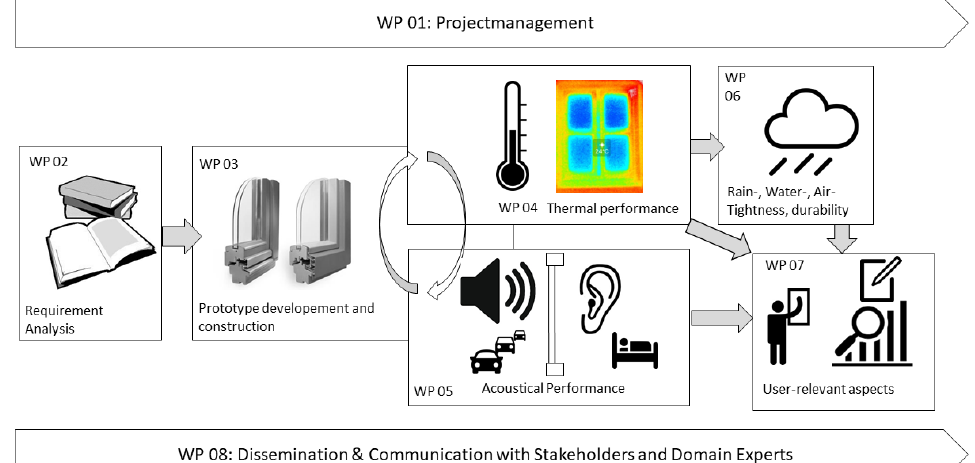
Figure 4. Work packages (WPs) of the project